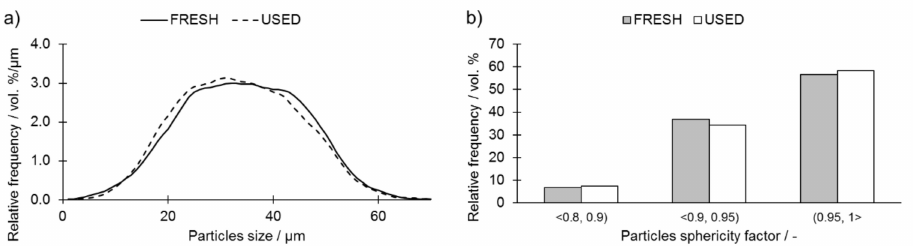
Figure 1. ( a ) particle size distribution and ( b ) particle sphericity histograms of the FRESH and the USED Ti6Al4V powders, highlighting the change in distribution of particle size and shape (in vol.%) in USED powder with respect to its FRESH counterpart.